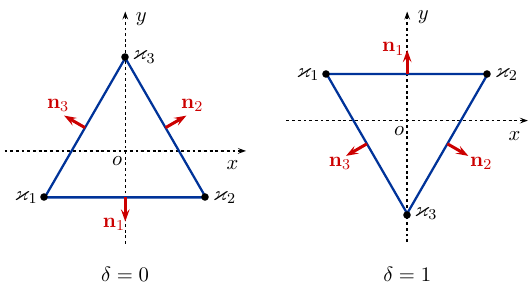
Fig. 3. Planar equilateral triangles considered in the truncation error analysis in Sect. 4.2.